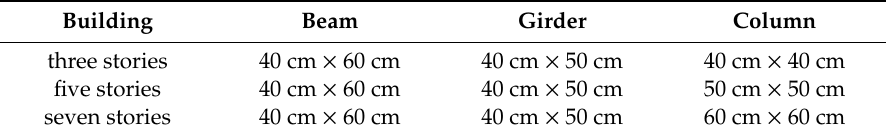
Table 1. Structural element sections for standard floor.